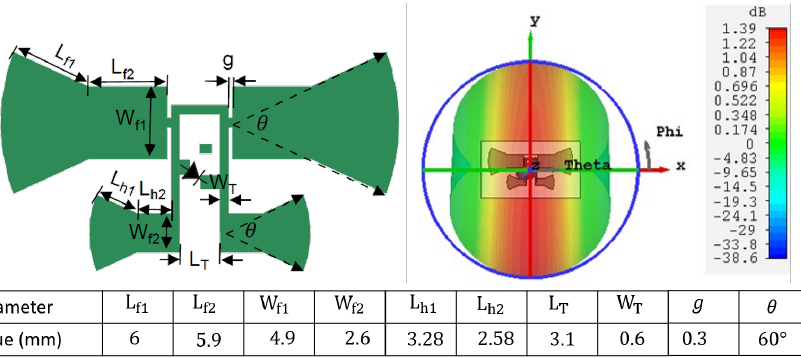
Figure 2. Harmonic transponder physical layout on the left and the corresponding radiation pattern at 2.45GHz on the